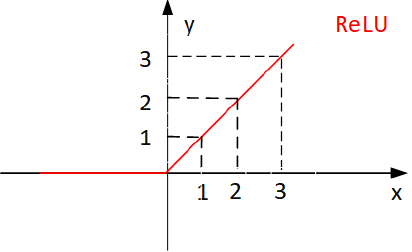
Figure 6. ReLU activation function